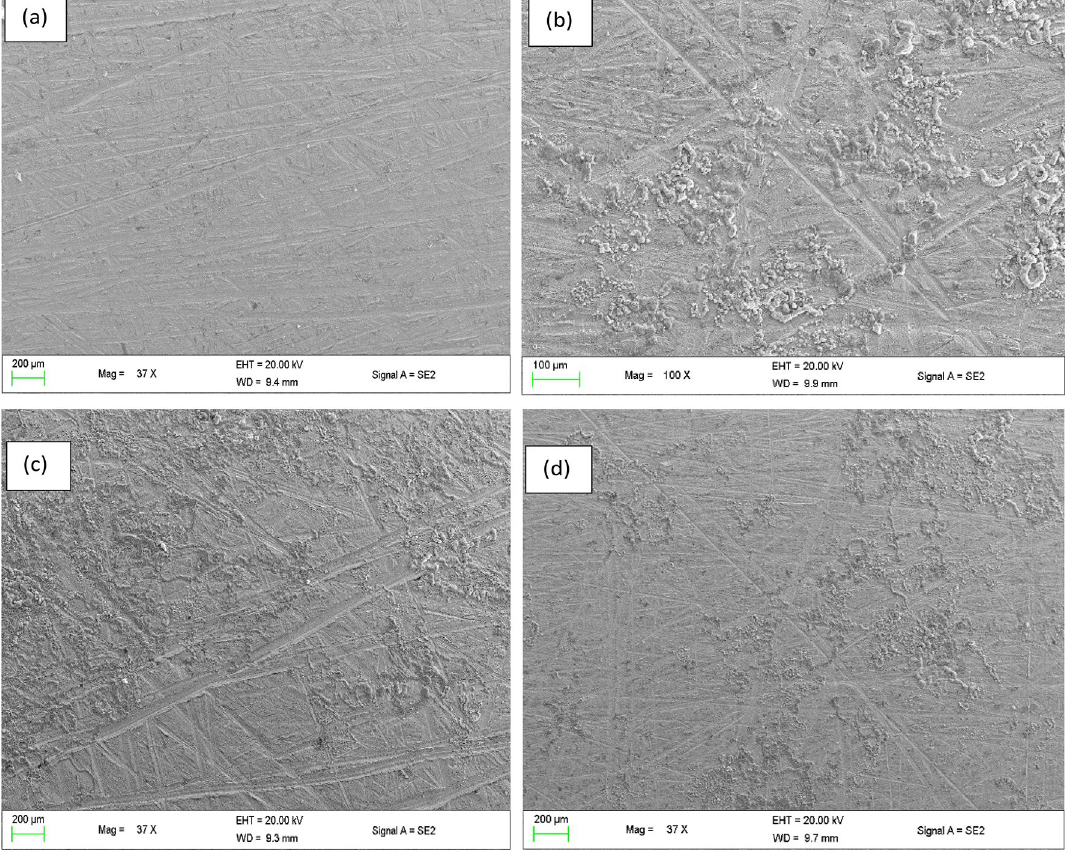
Figure 4. SEM micrographs of surface of mild steel ( a ) prior to immersion, ( b ) after 3 h immersion in 0.1 M HCl without inhibitors, ( c ) with 10 mM of L1 and(d)